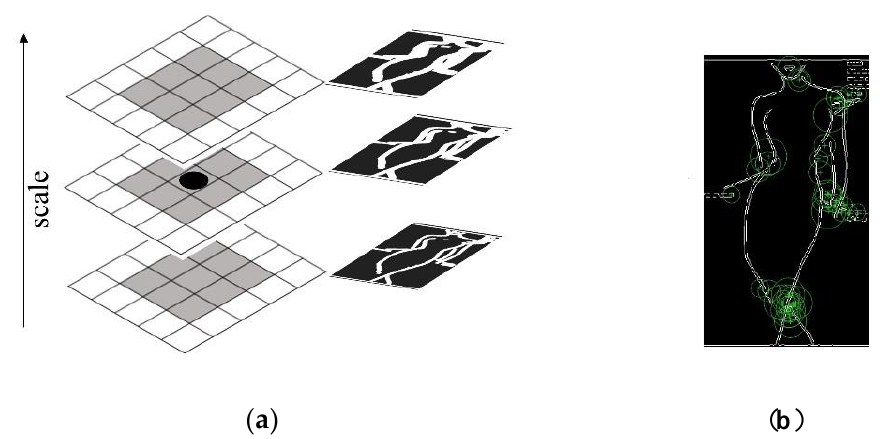
Figure 6. Scale invariance due to scale space model. The box type convolution filters are upscaled. The filtered images are given. Size of the box filters 9 × 9, 15 × 15 and 21 × 21 are applied. The non-maximal suppression is required to localize the most dominant feature in the scale space model. For the localization of feature points, a non-maximum suppression in a 3 × 3 × 3 neighborhood [40] is used to find the local maxima in a (x, y, σ ) space applied at image with detected feature points using non-maximal suppression.